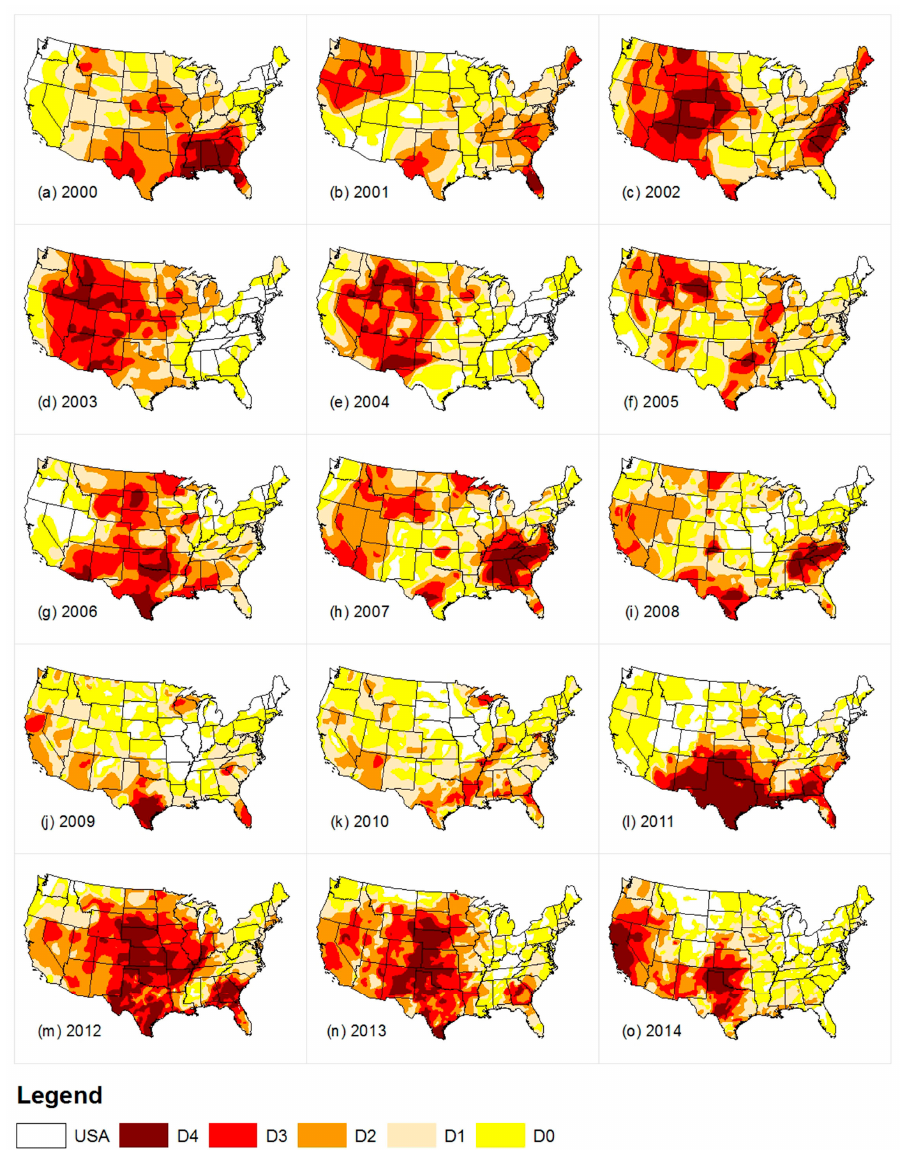
Figure 3. Areal coverage of the highest intensity of drought that an area experienced for years 2000–2014 ( a – o ).